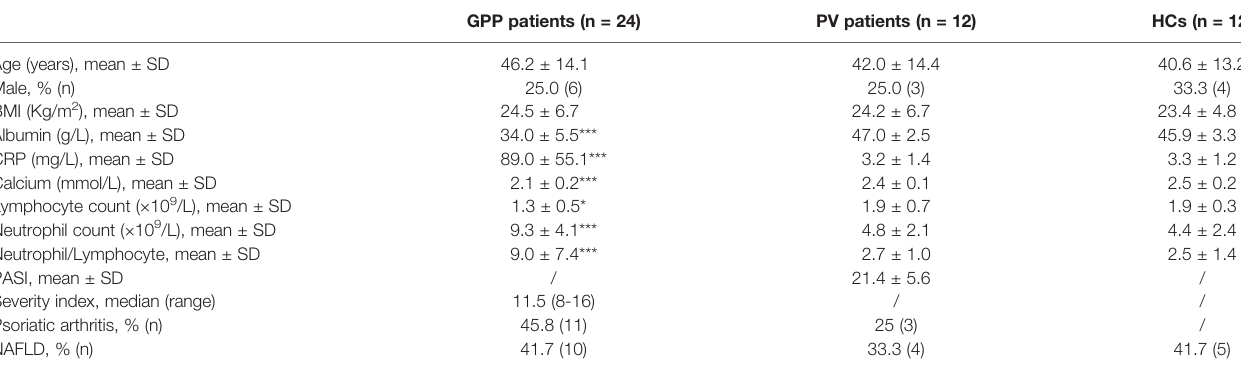
GPP, generalized pustular psoriasis; PV, psoriasis vulgaris; HCs, healthy controls; BMI, body mass index; CRP, C-reactive protein; PASI, psoriasis area and severity index; NAFLD, nonalcoholicfattyliverdisease;*P<0.05and***P<0.001forthedifferencebetweenGPPandHC,aswellasdifferencebetweenPVpatientsandhealthycontrols.P-valuesarecalculated according to ANOVA (continuous data) or Fisher ’ s exact test (categorical